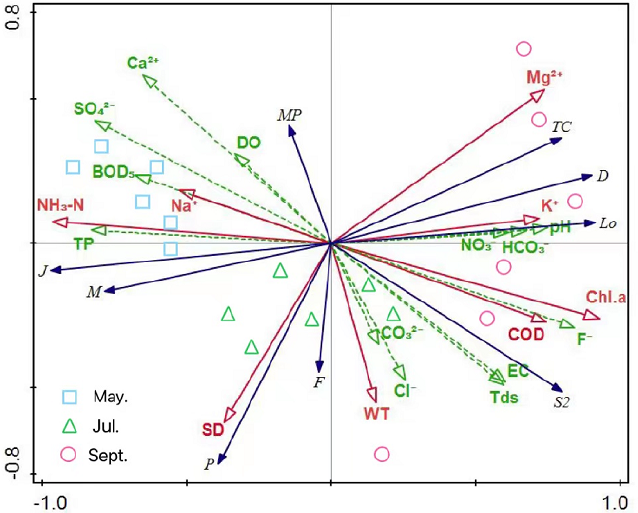
Figure 9. RDA − analysis − based relationship between the main species of phytoplankton and water quality indexes in Nanhai Lake.